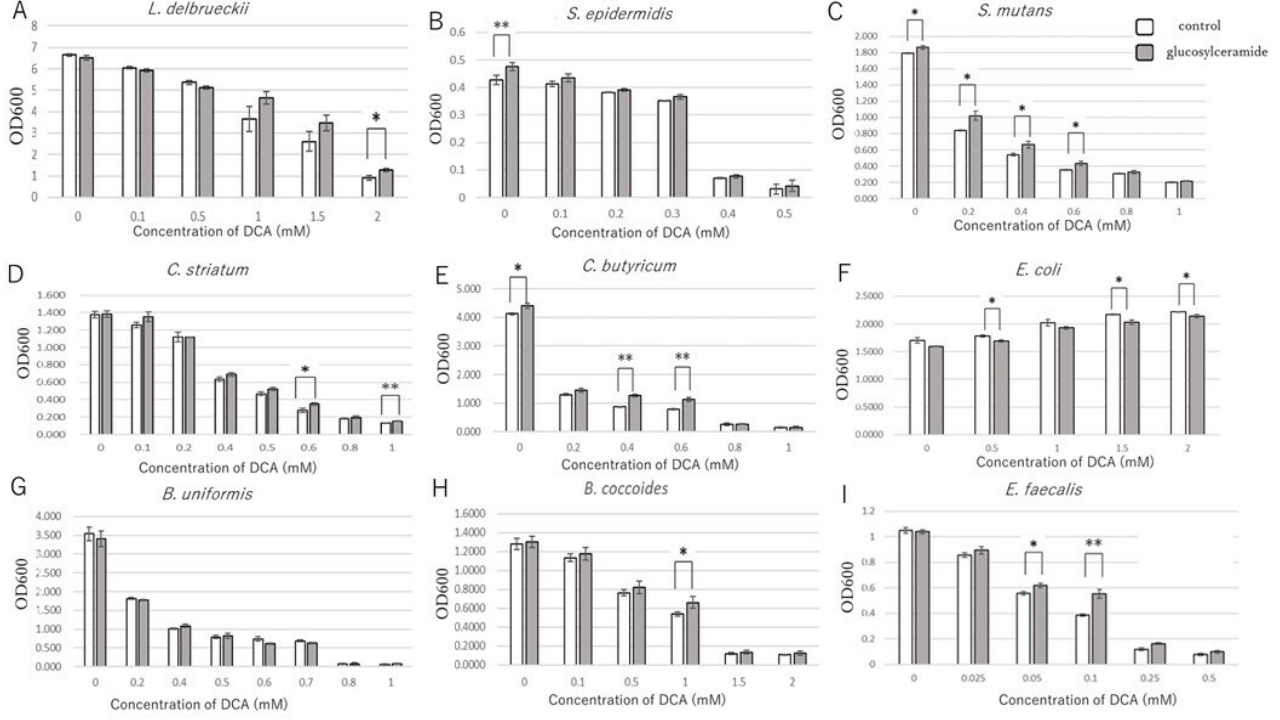
Figure 3. Growth of bacteria supplemented with various concentrations of deoxycholic acid (DCA) and glucosylceramide. OD 600 values for ( A ) L. delbrueckii, ( B ) S. epidermidis , ( C ) S. mutans , ( D ) C. striatum , ( E ) C. butyricum , ( F ) E. coli , ( G ) B. uniformis , ( H ) B. coccoides and ( I ) E. faecalis. Values are mean ± standard errors of triplicate independent cultures. Statistical differences of the means were evaluated by one-sided unpaired Student’s t -test ( n = 3, * p < 0.05, ** p < 0.01). Table 3. IC 50 of bacteria towards deoxycholic acid with or without glucosylceramide addition . IC 50 (mM)